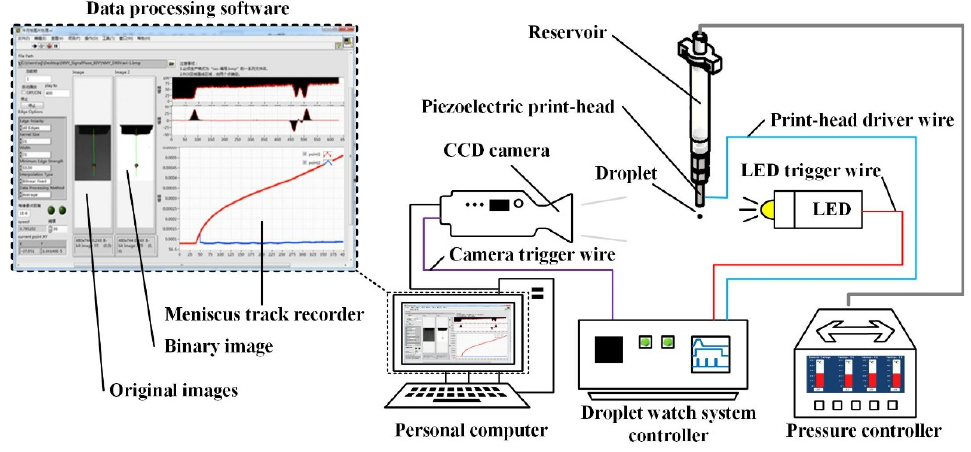
Figure 5. Schematic of the experimental system.